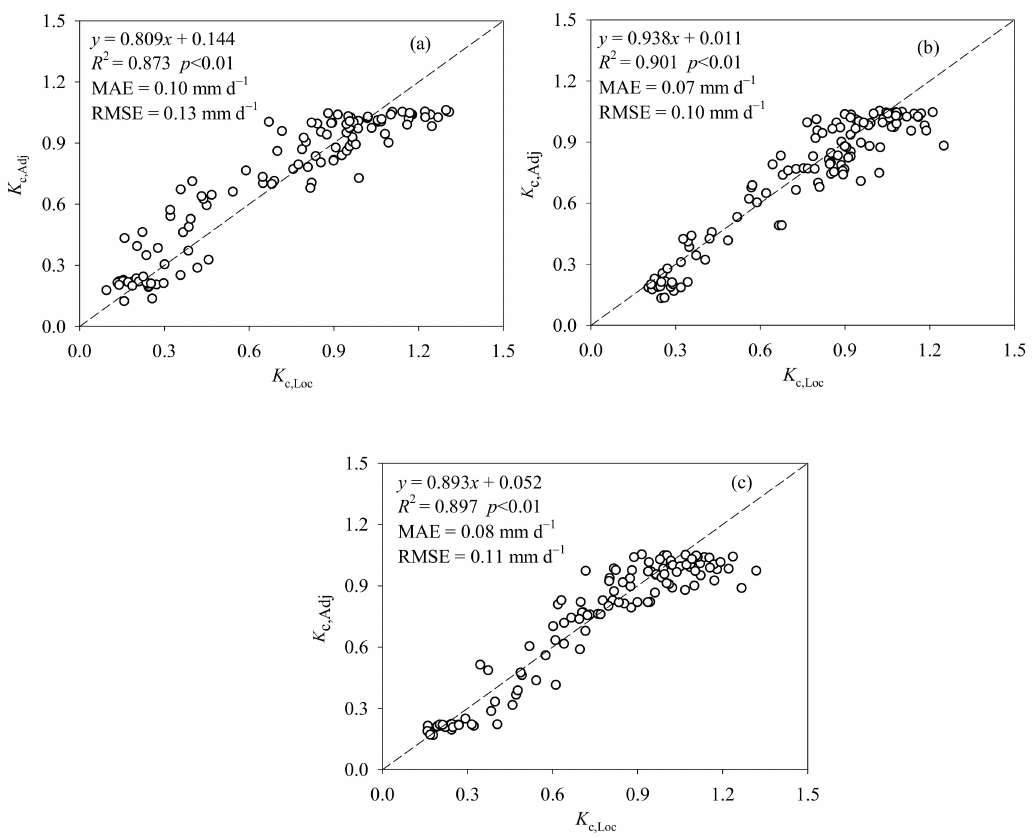
Figure 5. Comparison of local crop coefficient developed ( K c,Loc ) and adjusted crop coefficient ( K c,Adj ) for greenhouse-grown eggplant in the 2017 ( a ), 2018 ( b ), and 2019 ( c ) growing seasons. The dashed line represents a 1:1